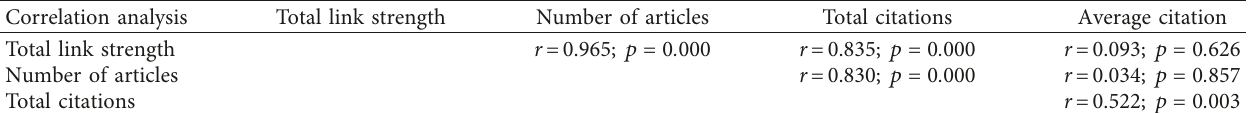
Table 4: The Pearson correlation analysis among parameters related to authors’ impact on PPP research